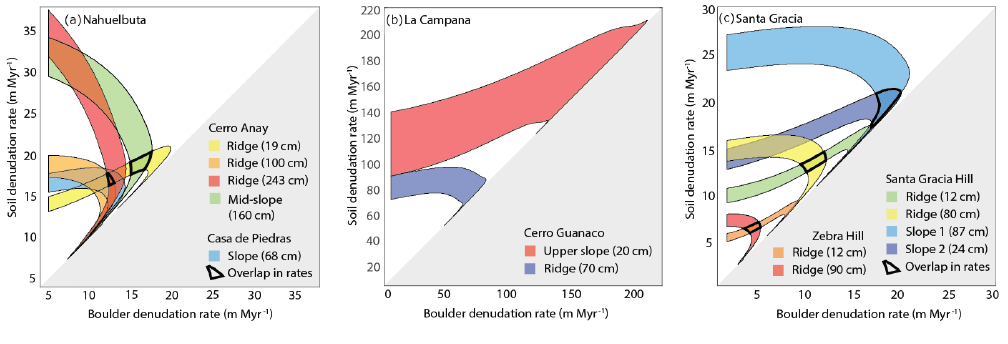
Figure 6. Range of best-fitting combinations of modeled soil and boulder denudation rates in (a) Nahuelbuta, (b) La Campana, and (c) Santa Gracia according to Eq. (1). Each color band corresponds to an amalgamated boulder sample, listed in the legend along with the average protrusion height of the boulders. Areas where best-fitting denudation rates overlap for samples from the same location are highlighted by a black outline. The gray areas are forbidden fields, as by assumption, boulder denudation rates have to be lower than soil denudation rates; otherwise, there would be no boulder protruding above the soil